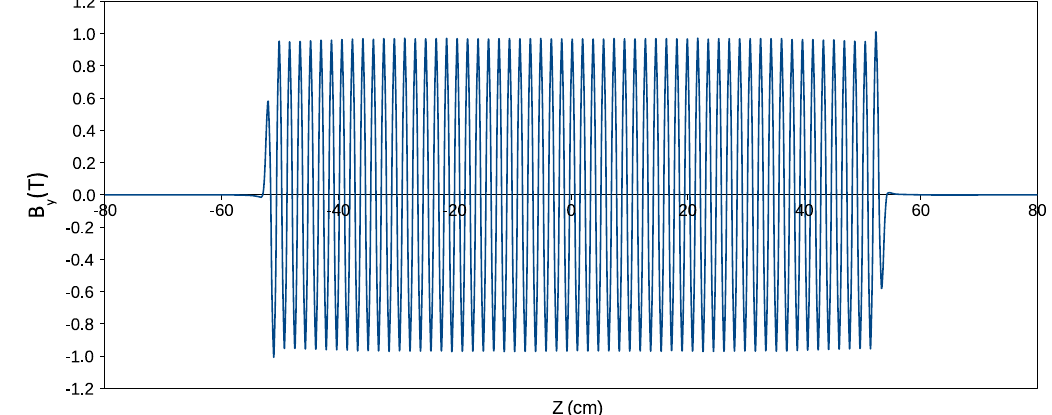
FIG. 10. Measured undulator field profile at magnet current of 450 A.